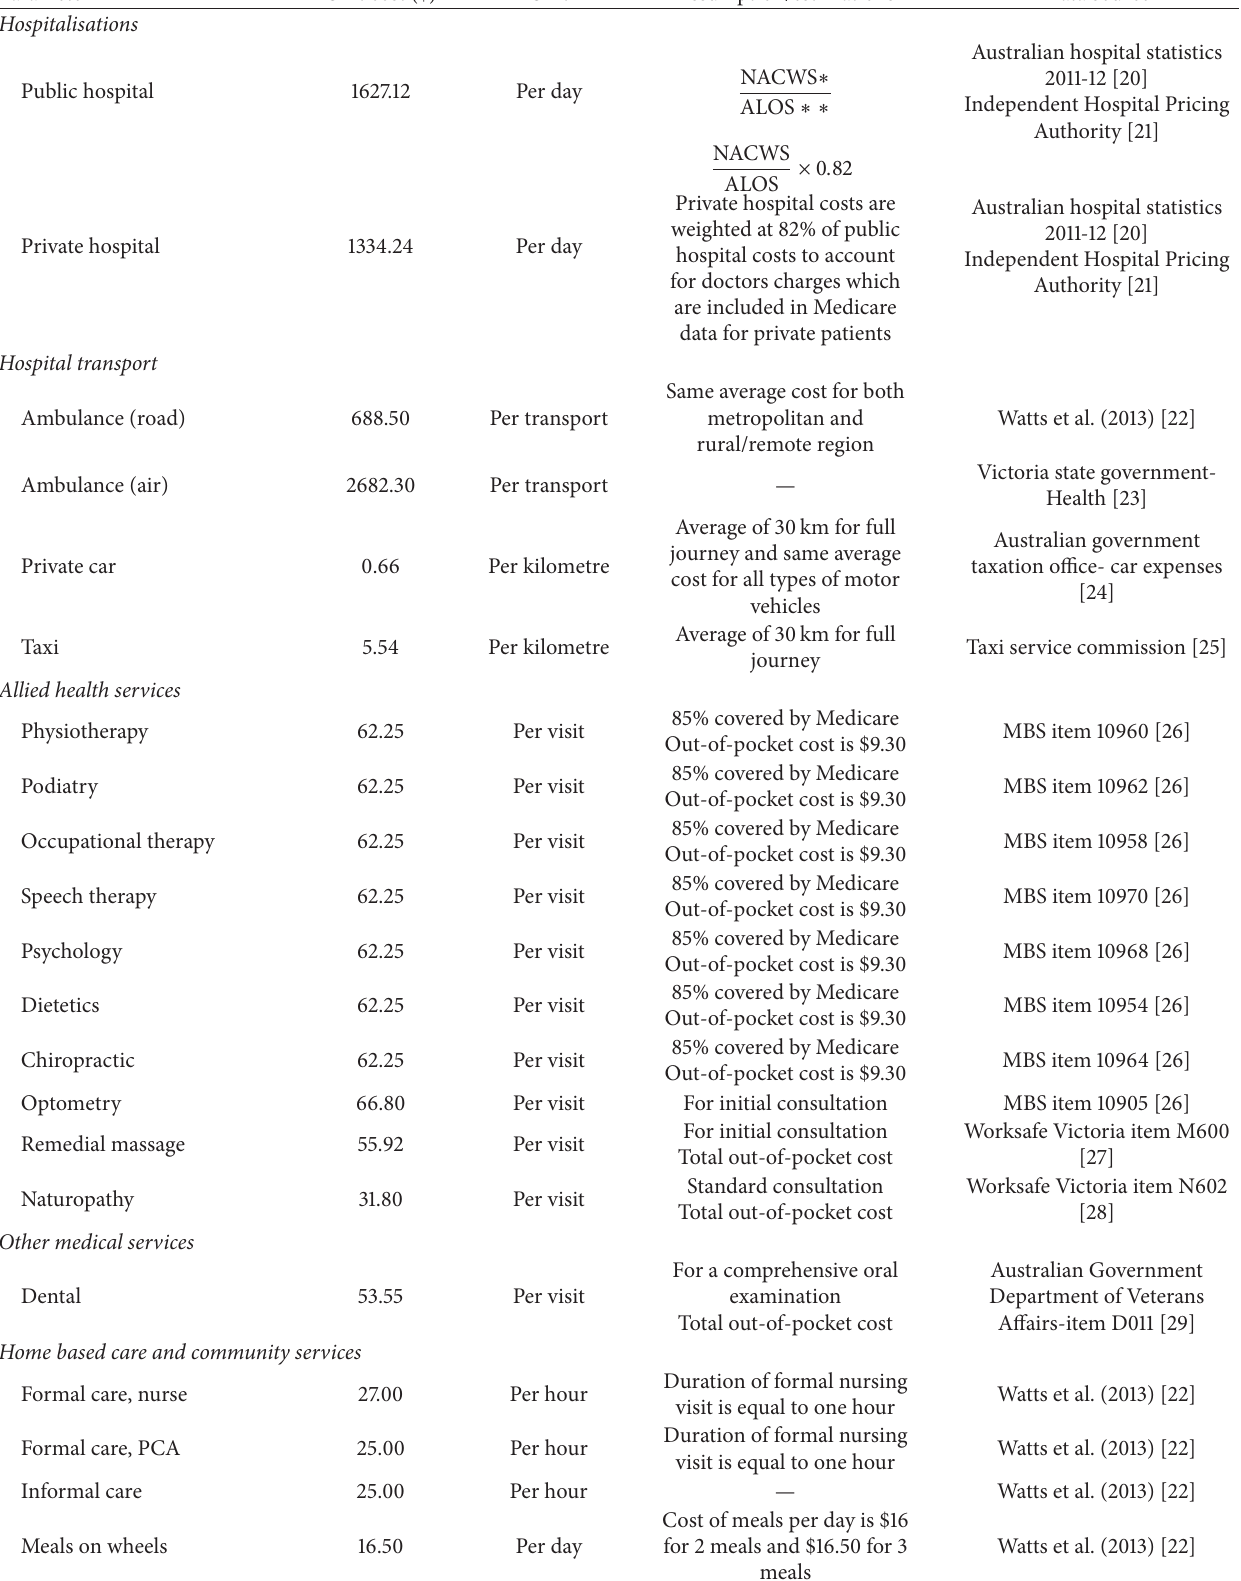
Table 2: Unit costs and assumptions for cost